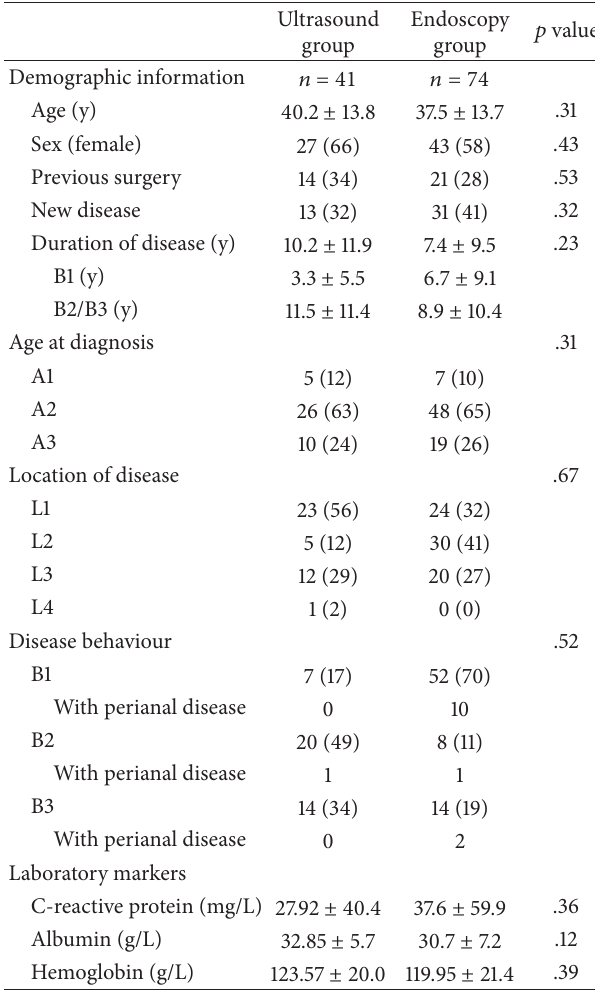
Table 1: Demographics, Montreal classification, and laboratory markers of ultrasound and endoscopy